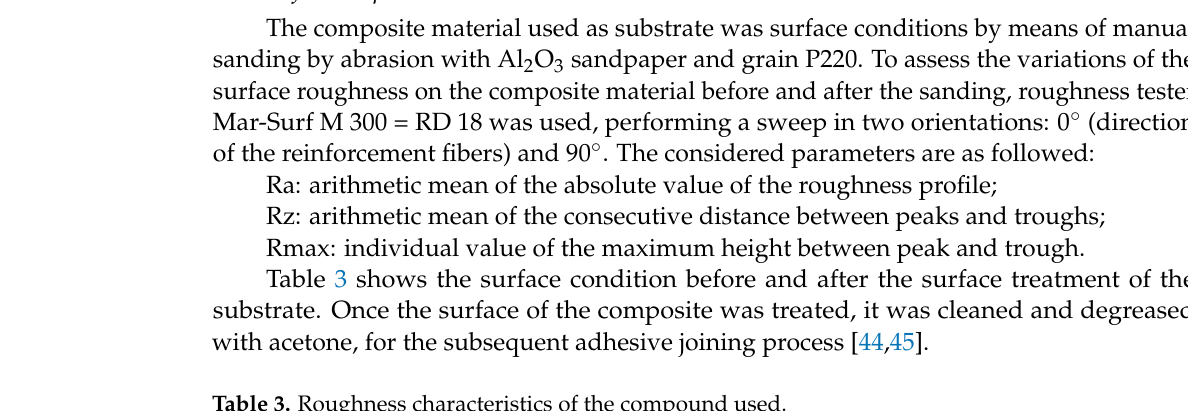
Table 3. Roughness characteristics of the compound